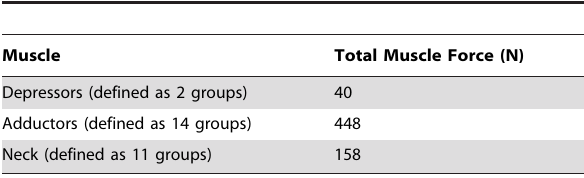
Table 3. Total muscle forces applied to each side of the skull during the MDA.